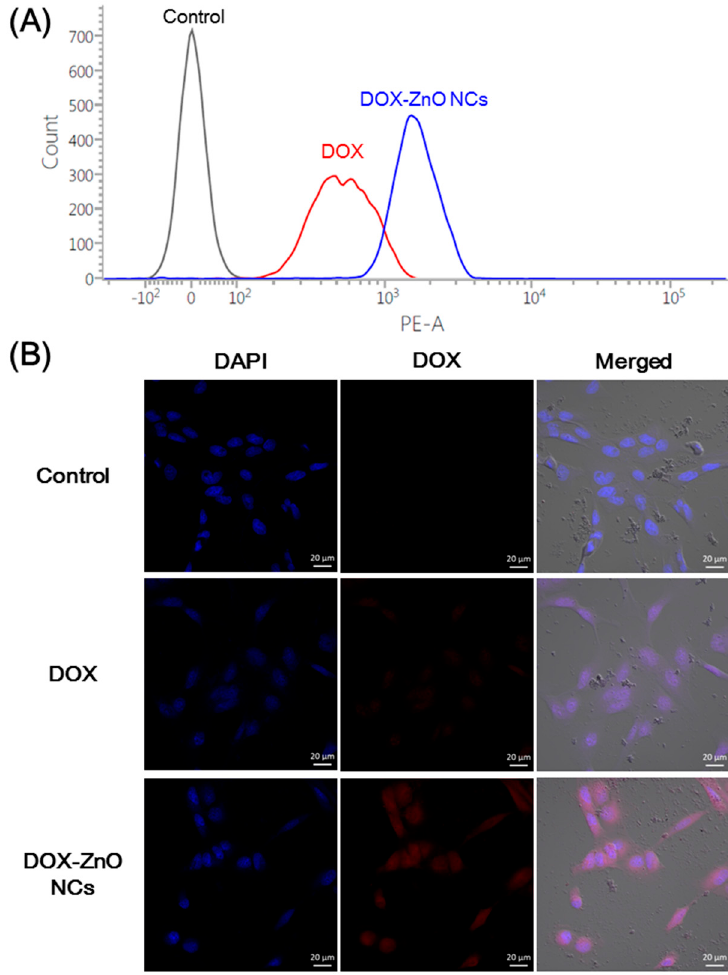
Figure 6. Cellular uptake tests of developed NCs in Caco-2 cells. ( A ) Cellular internalization efficiency of developed NCs in Caco-2 cells measured by flow cytometry. The cell count profiles according to the fluorescence intensity of each group after 2 h incubation are presented. Black, red, and blue colors indicate control, DOX, and DOX-ZnO NCs, respectively. Representative profile of triplicate is shown; ( B ) Intracellular distribution of NCs in Caco-2 cells observed by CLSM imaging. DOX and DOX-ZnO NCs were incubated for 2 h and CLSM images were acquired. Red and blue colors indicate DOX and 4 ′ ,6-diamidino-2-phenylindole (DAPI), respectively. The length of scale bar in the image is 20 μ m.